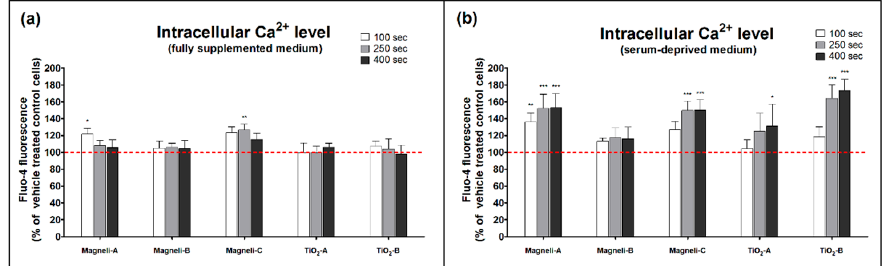
Figure 4. Intracellular Ca 2+ level in A549 cells after 100, 250, and 400 s exposure to nanoparticles in ( a ) fully supplemented cell medium and in ( b ) serum-deprived cell medium. For the evaluation of the intracellular Ca 2+ level, Ca 2+ -sensitive Fluo-4 dye was used. For each treatment condition, three independent repetitions with fluorescence of at least 20 individual cells were evaluated. Results are presented as an average Fluo-4 fluorescence (+SD) according to vehicle treated control cells (dashed line). An asterisk represents a significant difference with respect to the control cells (* equals p < 0.05; ** equals p < 0.01; *** equals p < 0.001; ANOVA with Bonferroni’s post test).